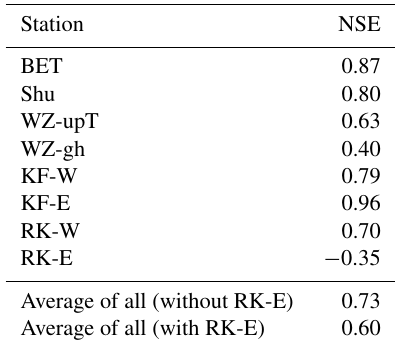
Table B3. NSE statistics of SM obs versus SM mod